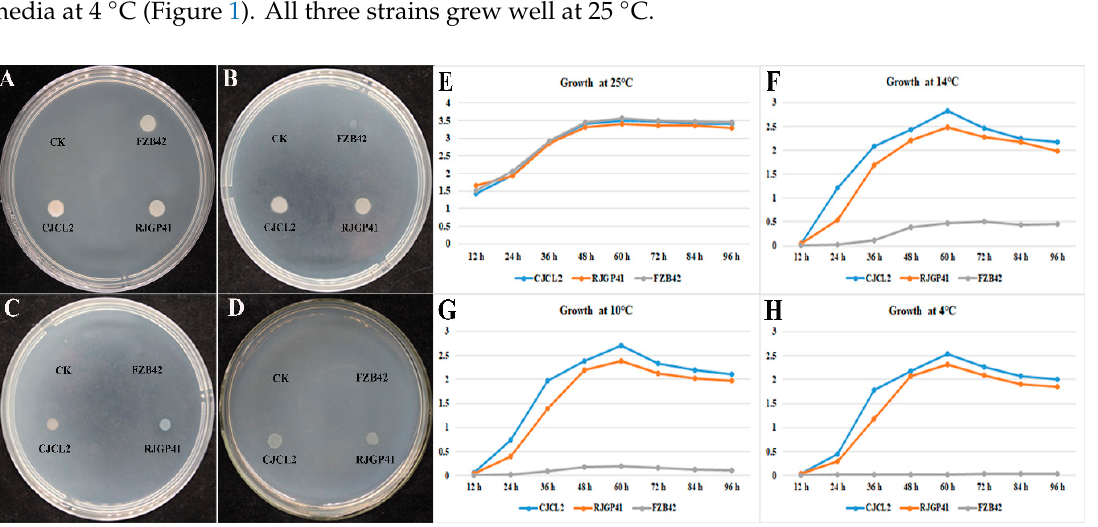
Figure 1. The colony growth of Bacillus strains grown on LB agar media and incubated at 25 °C for 96 h ( A ), at 14 °C for 96 h ( B ), at 10 °C ( C ), and at 4 °C ( D ). The growth curves indicated by OD 600 of 96 h ( A ), at 14 ◦ C for 96 h ( B ), at 10 ◦ C ( C ), and at 4 ◦ C ( D ). The growth curves indicated by OD 600 of selected bacteria at 25 °C ( E ), 14 °C ( F ), 10 °C ( G ), and 4 °C ( H ) as measured by spectrophotometer at selected bacteria at 25 ◦ C ( E ), 14 ◦ C ( F ), 10 ◦ C ( G ), and 4 ◦ C ( H ) as measured by spectrophotometer at different time intervals. The experiment was repeated thrice with similar results. di ff erent time intervals. The experiment was repeated thrice with similar